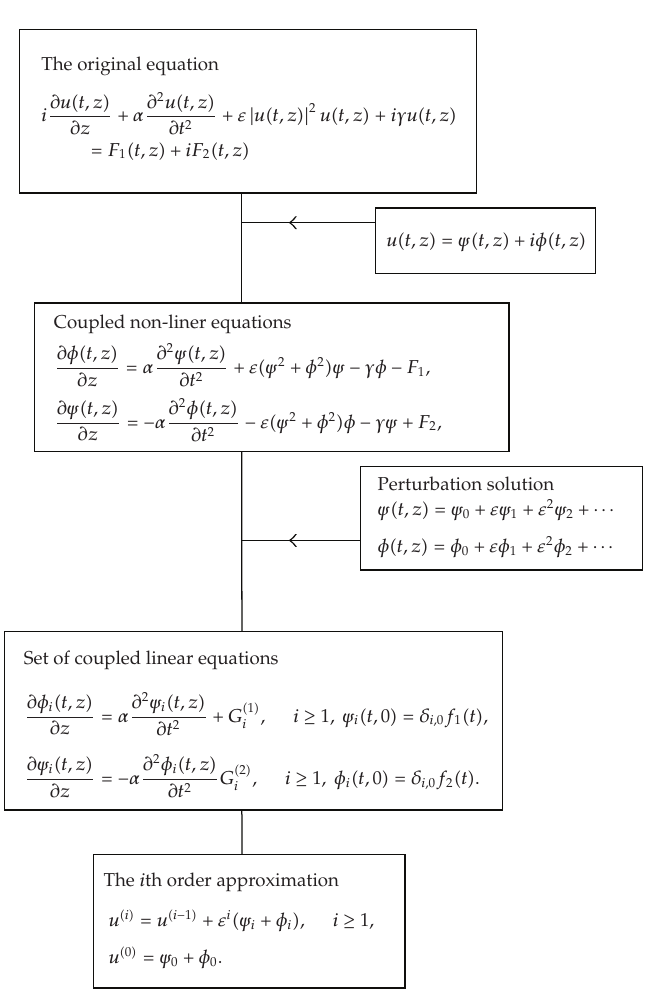
Figure 39: The general solution